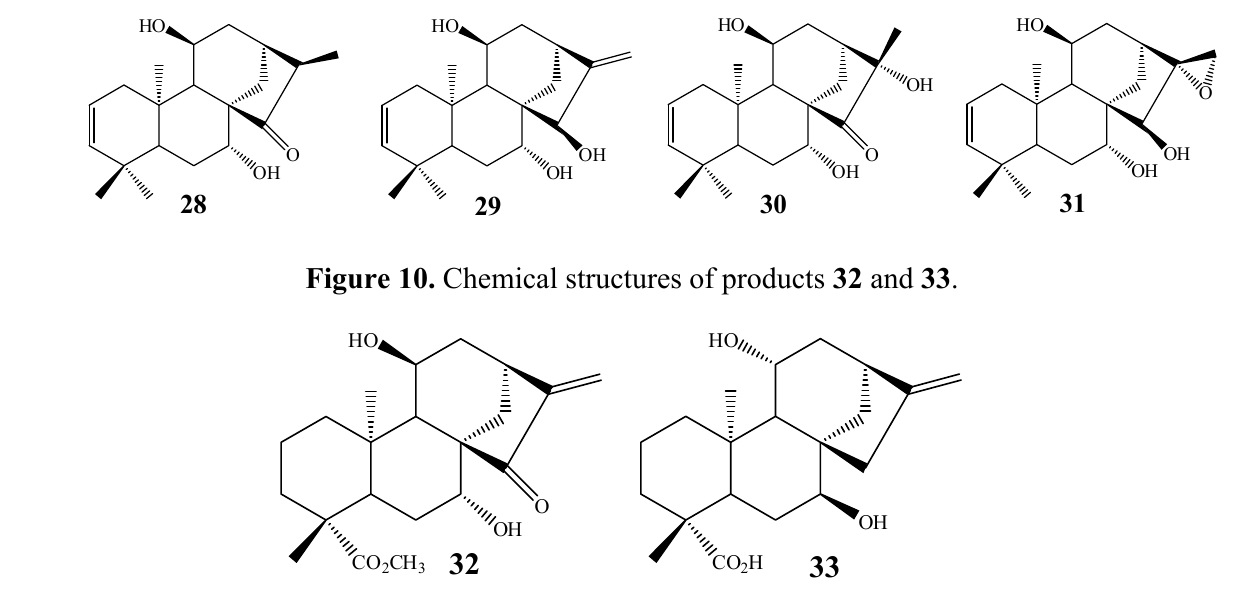
Figure 11. Chemical structures of starting material 34 and products hydroxylated in C-6/C- 11 and C-7/C-13 by the fungi G. fujikuroi and A. blakesleeana